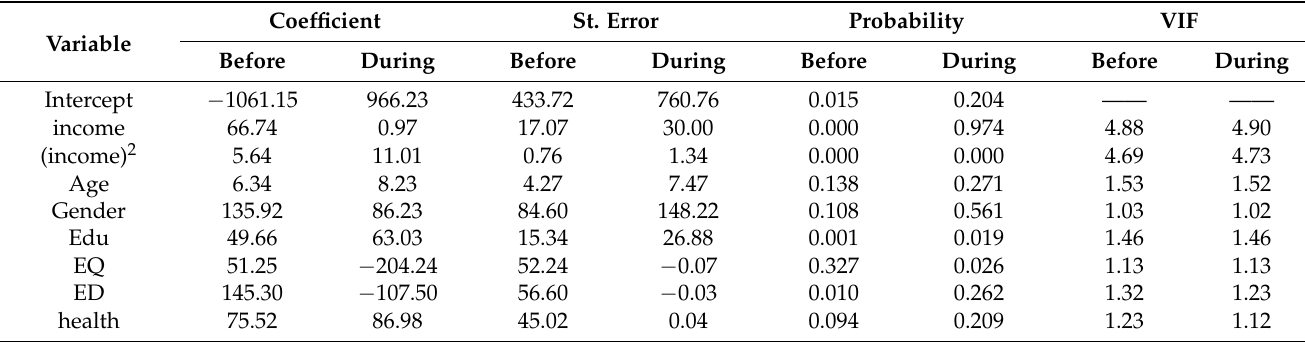
Table 3. Summary statistics of the linear regression